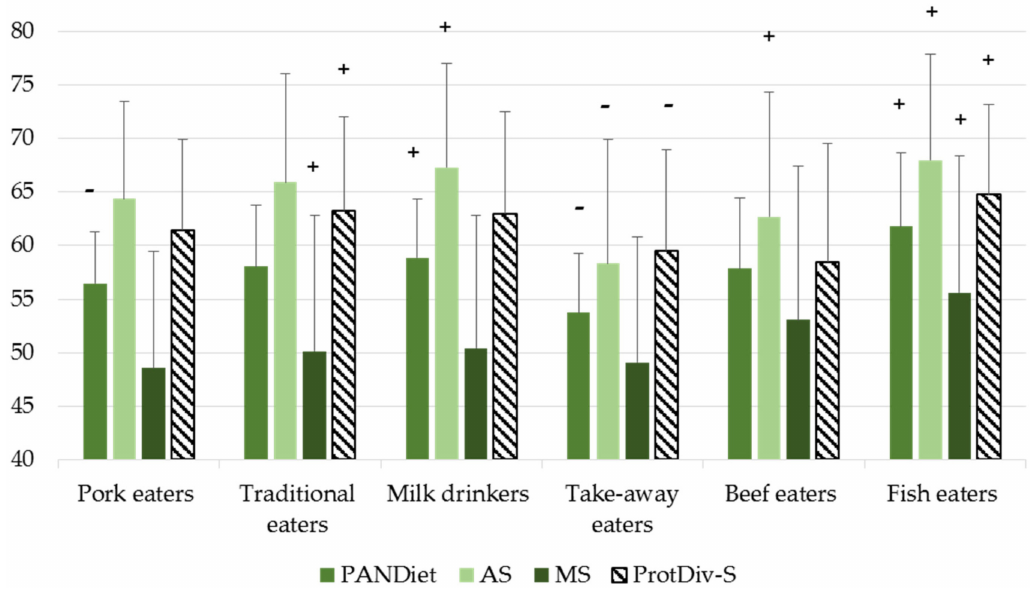
Figure 3. PANDiet, AS, MS and ProtDiv-S of protein dietary patterns in INCA2 study ( n = 1678). Only those patterns which differed significantly from those of the general population for at least one parameter are shown. Significant differences are represented with a “+” if the parameter in the cluster was higher than in the overall population, and a “-“ if the parameter in the cluster was lower. AS, Adequacy Subscore. MS, Moderation Subscore. ProtDiv-S, Protein Diversity